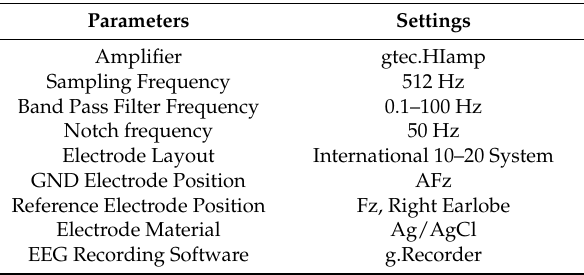
Table 2. Parameter settings of EEG recording system.